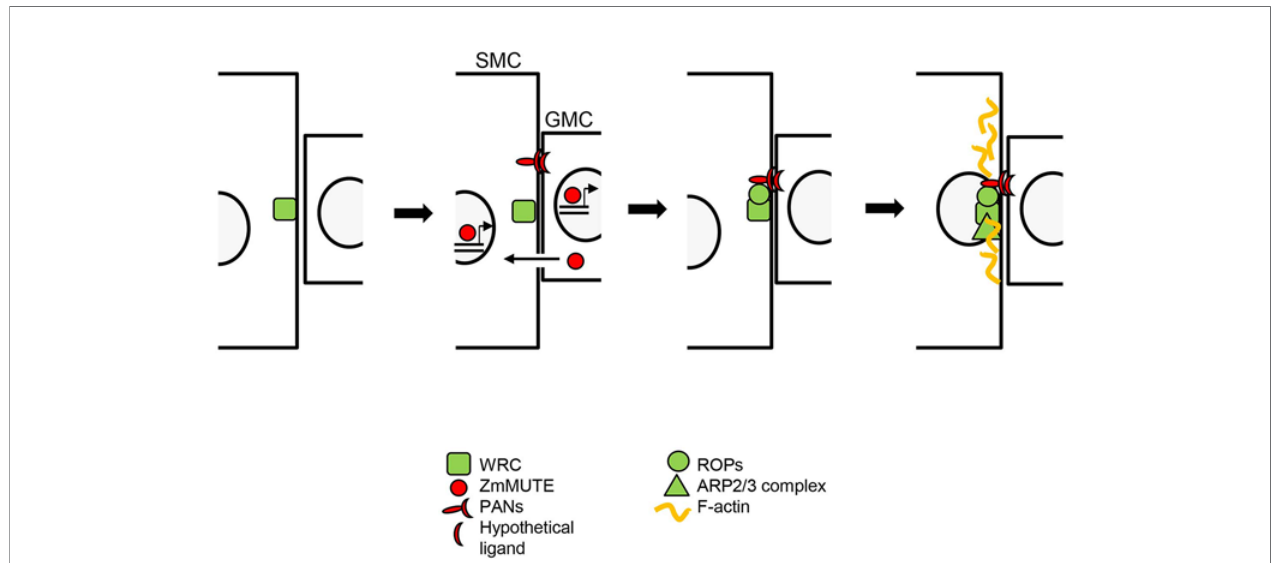
FIGURE 2 | ZmMUTE role during the polarization of the subsidiary mother cell (SMC) in maize. The WAVE regulatory complex (WRC) complex polarizes to the cell surface of the SMC, at the site of guard mother cell (GMC) contact. ZmMUTE moves from the GMC to SMCs, where it binds to PANs promoters and promotes their induction. PANs accumulate, in a WRC-dependent manner, at the SMC / GMC contact site. PANs then recruit and activate ROPs. Activated ROPs physically interact and activate the WRC, which activates the ARP2/3 complex. Finally, ARP2/3 activity produces a dense F-actin patch and promotes nuclear migration towards